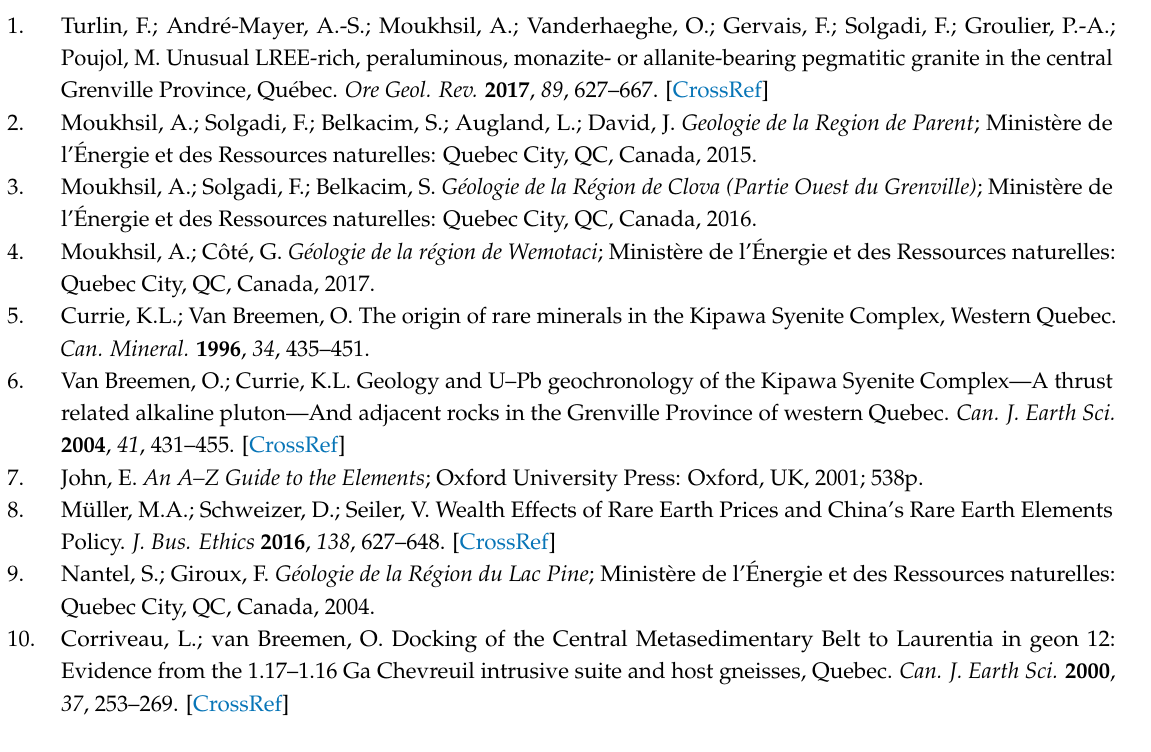
Table S1: Localisation and results of the geochemical date, Table S2; Microprobe analysis, Table S3: Microprobe analysis